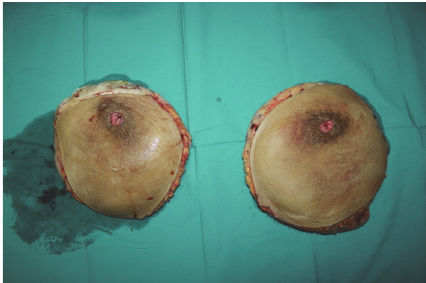
Figure 2: Resected breast tissue. Total amount of 7300 grams of tissue was removed (right breast = 3500 grams; left breast = 3800